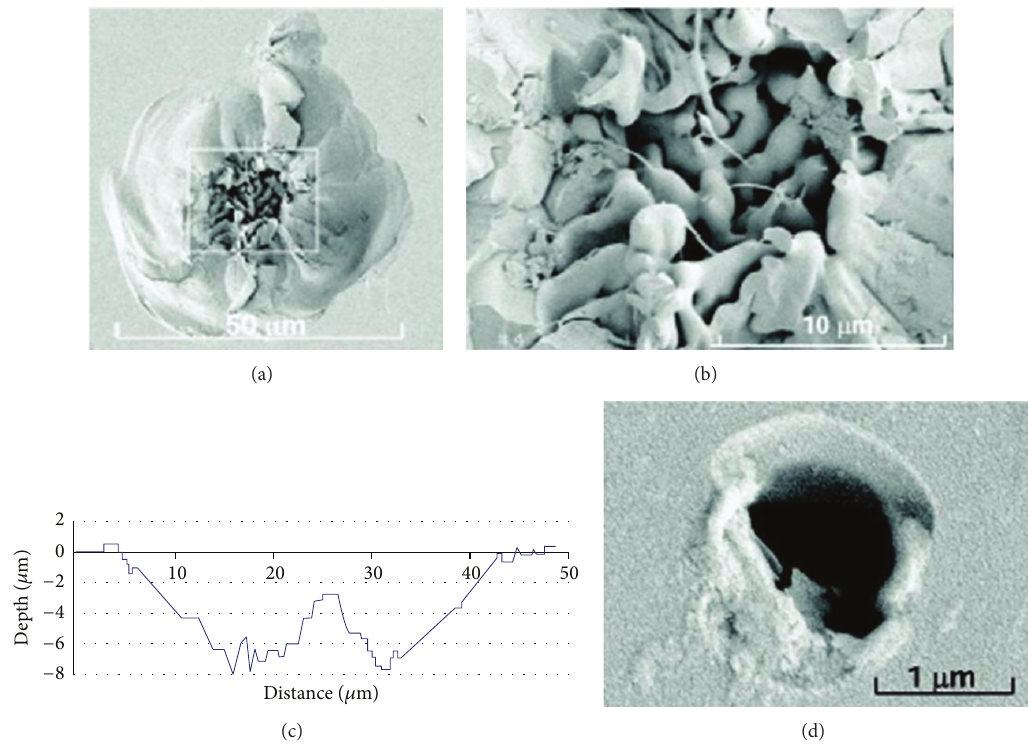
Figure 4: Damage craters produced in fused silica by 355 nm, 7.5ns pulse with 45 J/cm 2 fluence: (a) large crater with melted central core and fractured periphery; (b) magnified image of the central core; (c) cross-sectional profile of the crater shown in (a); (d) small craters produced by melting and evaporation